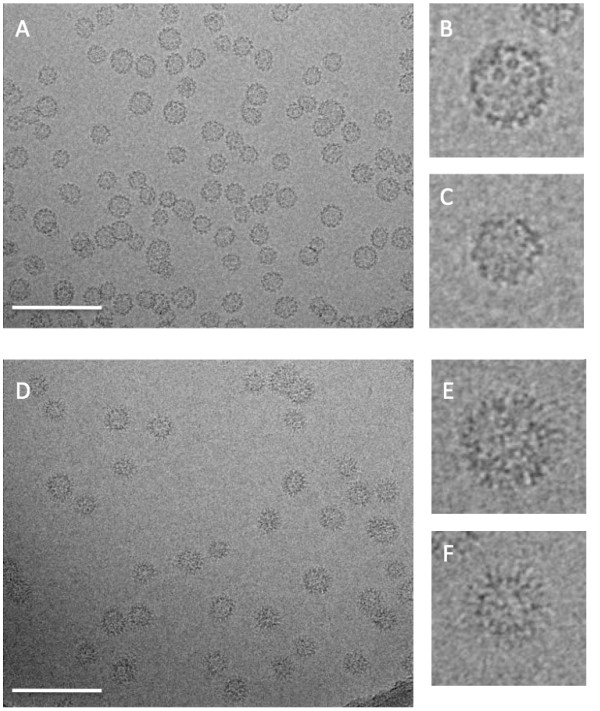
(A) CryoEM image of HPV 16 VLPs post-D/R treatment shows a field of well-formed closed spherical particles. (B,C) Larger scale images of individual VLP particles show that the individual capsomeres are arranged with a high degree of order. (D) CryoTEM image of post D/R HPV 16 VLPs mixed with H16.V5 Fab shows a similar field of particles densely decorated with antibody fragment. (E, F) Larger scale images of individual particles show that the antibody attachment is independent of the diameter of the individual particles. Scale bar is 200 nm.